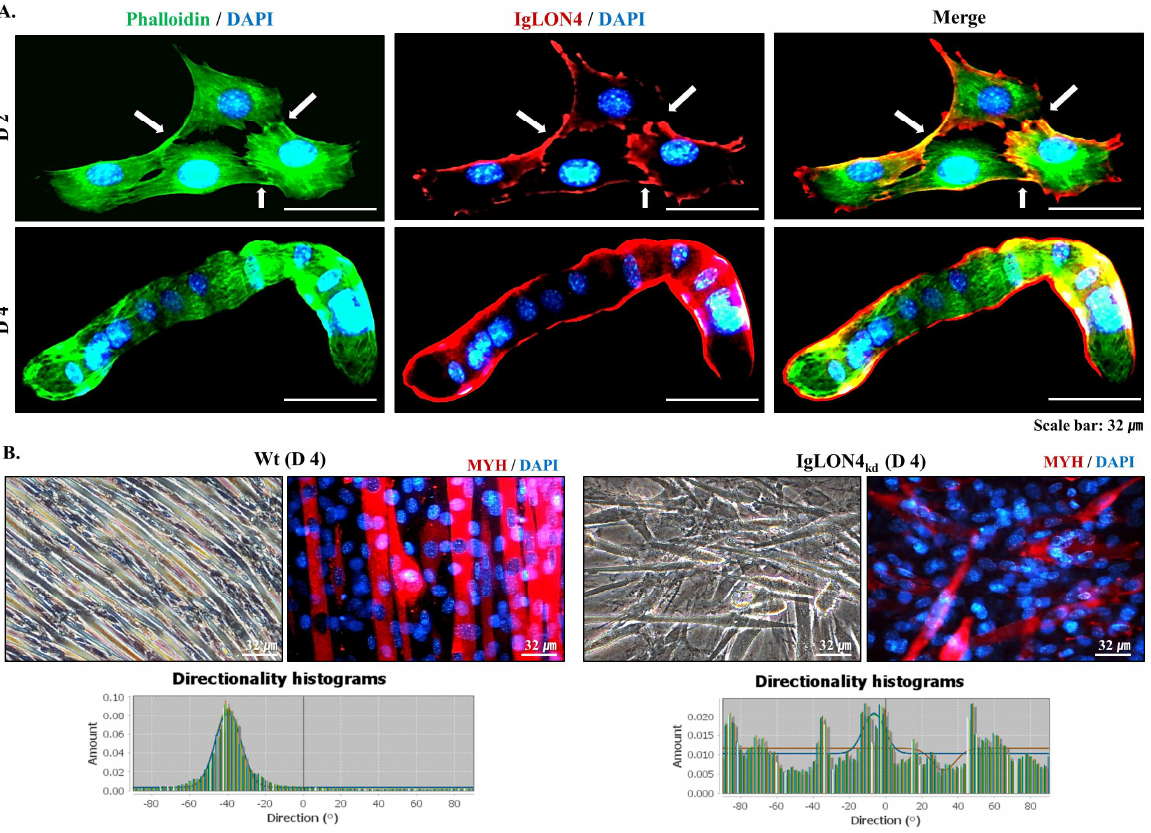
Figure 4. IgLON4 protein expression and myotube orientation in Wt and IgLON4 kd C2C12 myoblasts during differentiation: ( A ) IgLON4 protein locations were determined by immunocytochemistry on differentiation days (DDs) 2 and 4. Phalloidin and IgLON4 were fluorescently labeled green and red, respectively. Phalloidin was used for counterstaining cytoskeletal actin filaments. ( B ) Myotube formation was observed by MYH immunocytochemistry in Wt and IgLON4 kd cells on DD4. Directional analysis of myotube formation by Wt and IgLON4 kd cells was performed using ImageJ on DD4. Wt indicates transfection with a scrambled vector.